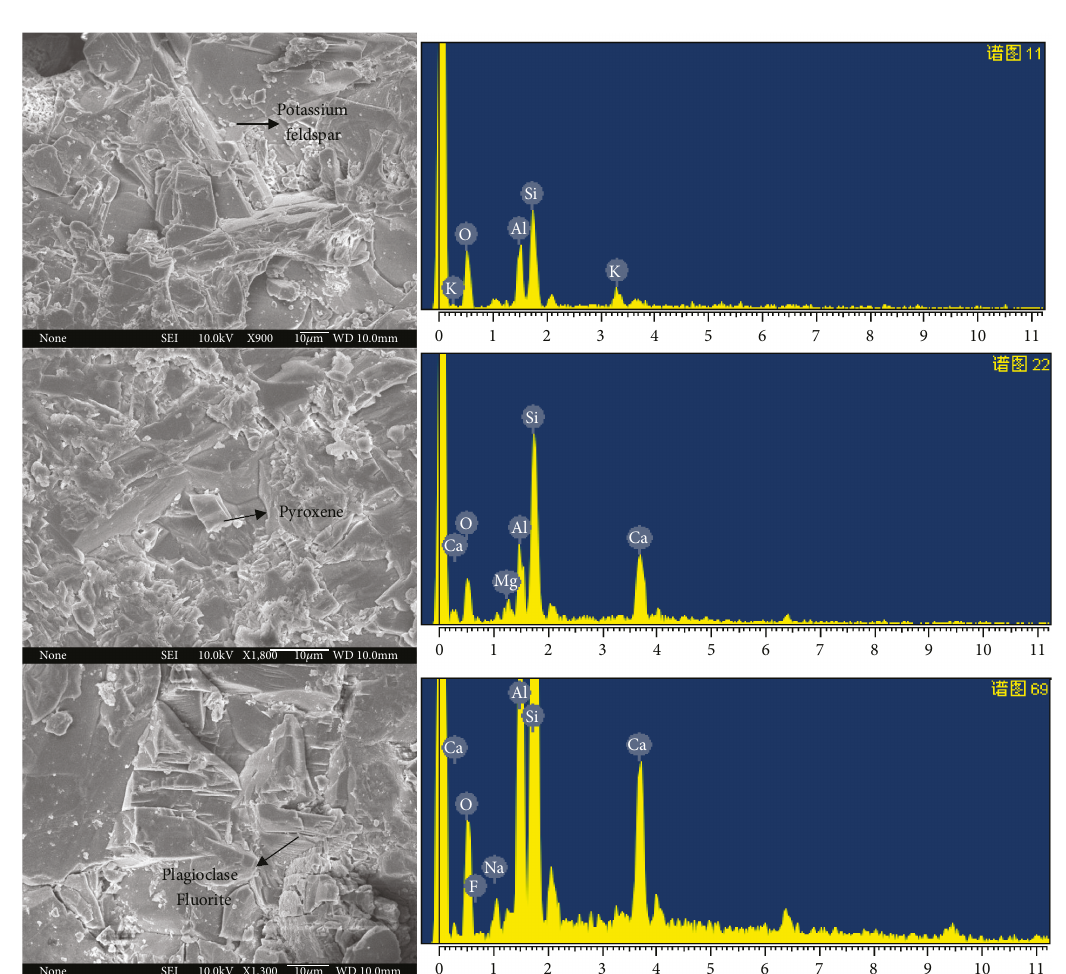
Figure 8: Scanning electron microscopic (SEM) and energy dispersion spectrum (EDS) diagrams of rock